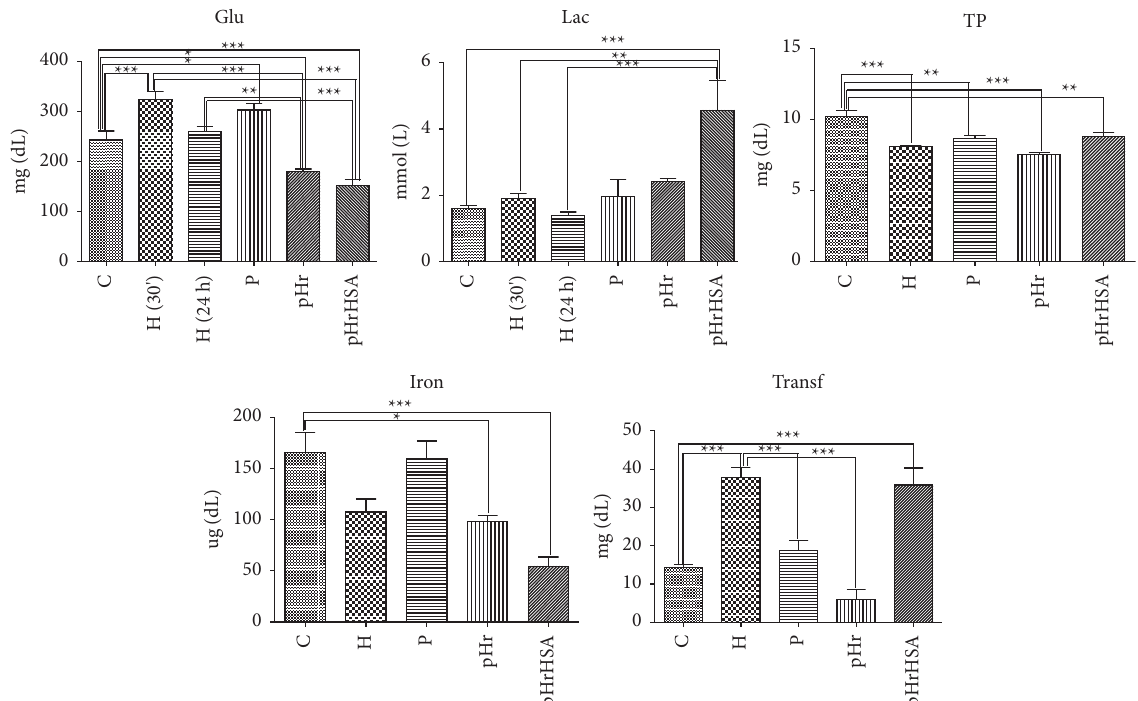
Figure 2: Transferrin, iron, total proteins, glucose, and lactate in control and experimental animals. ∗ Signifcant at p < 0 . 05; ∗∗ signifcant at p < 0 . 01; ∗∗∗ signifcant at p < 0 .